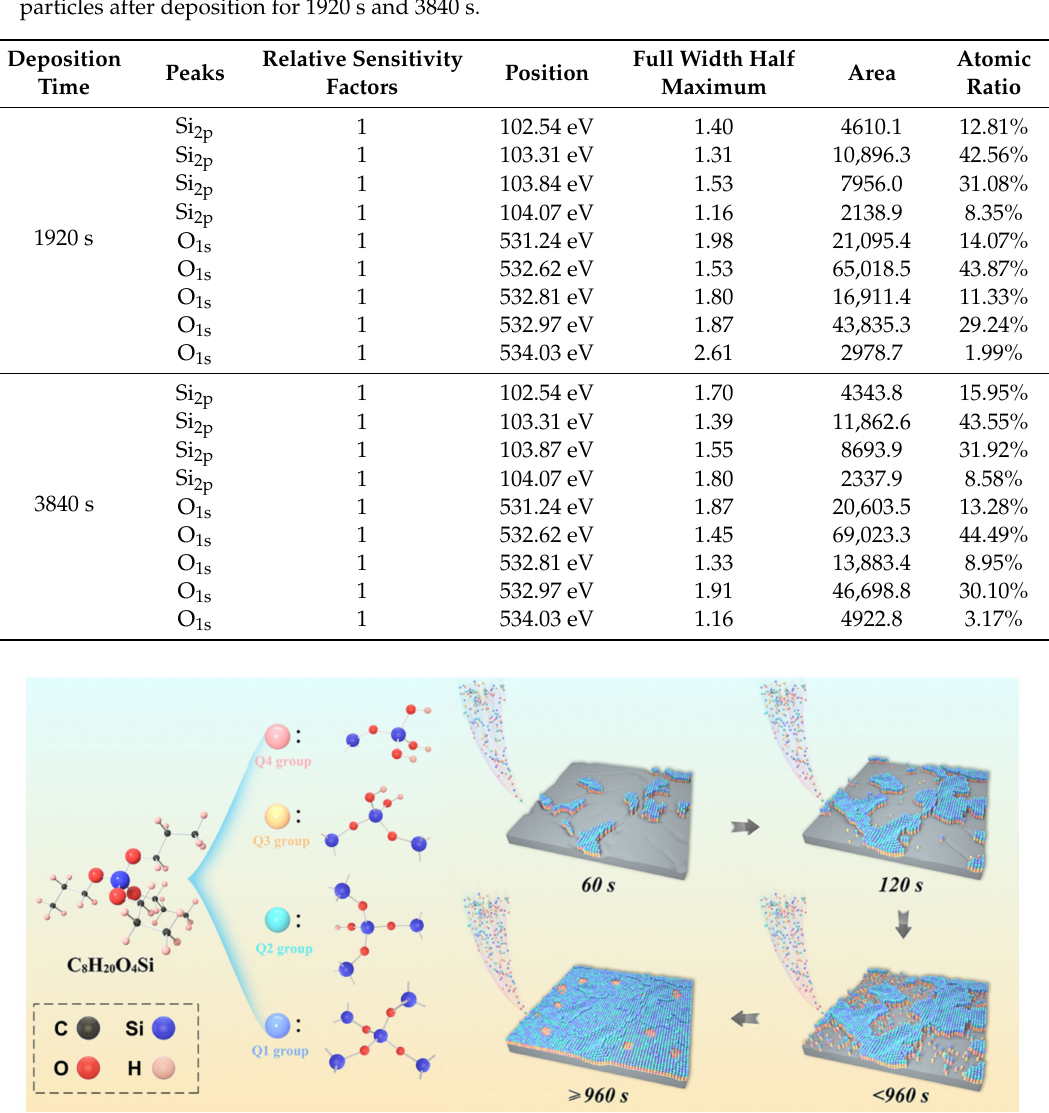
Figure 5. Schematic illustration of the Fe-6.5wt.%Si / SiO 2 C-S structural formation process during